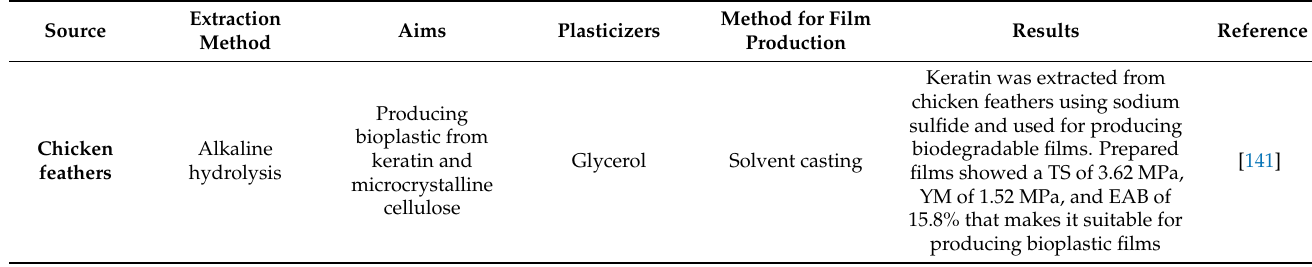
Table 4. Keratin films developed from different animal by-product